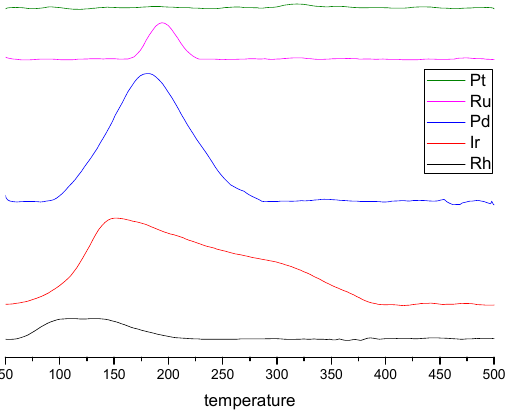
Figure 3. H 2 -TPR (temperature programmed reduction) patterns of the different catalysts (°C).